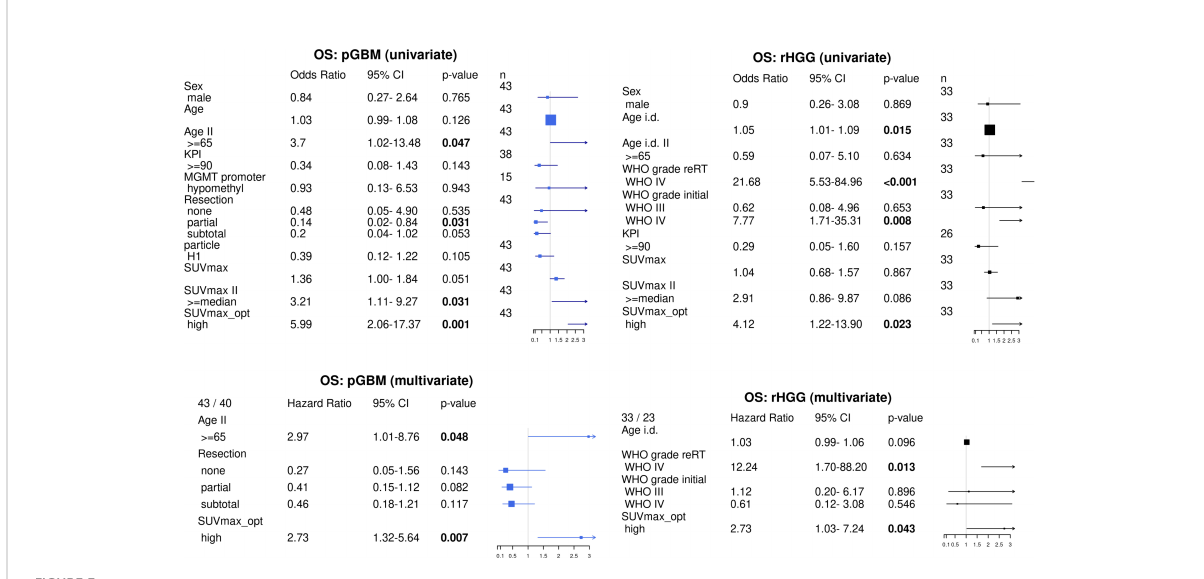
FIGURE 3 Uni- and multivariate survival analyses in pGBM and rHGG. Univariate analysis: parametric survival model (log-logistic distribution). pGBM: reference level for resection: biopsy. Age i.d.: age at initial diagnosis. Multivariate analysis includes variables signi fi cant in univariate analysis, Cox PH survival model. SUVmax_opt: optimal separation (minimal p-value). pGBM, primary glioblastoma; rHGG, recurrent high-grade